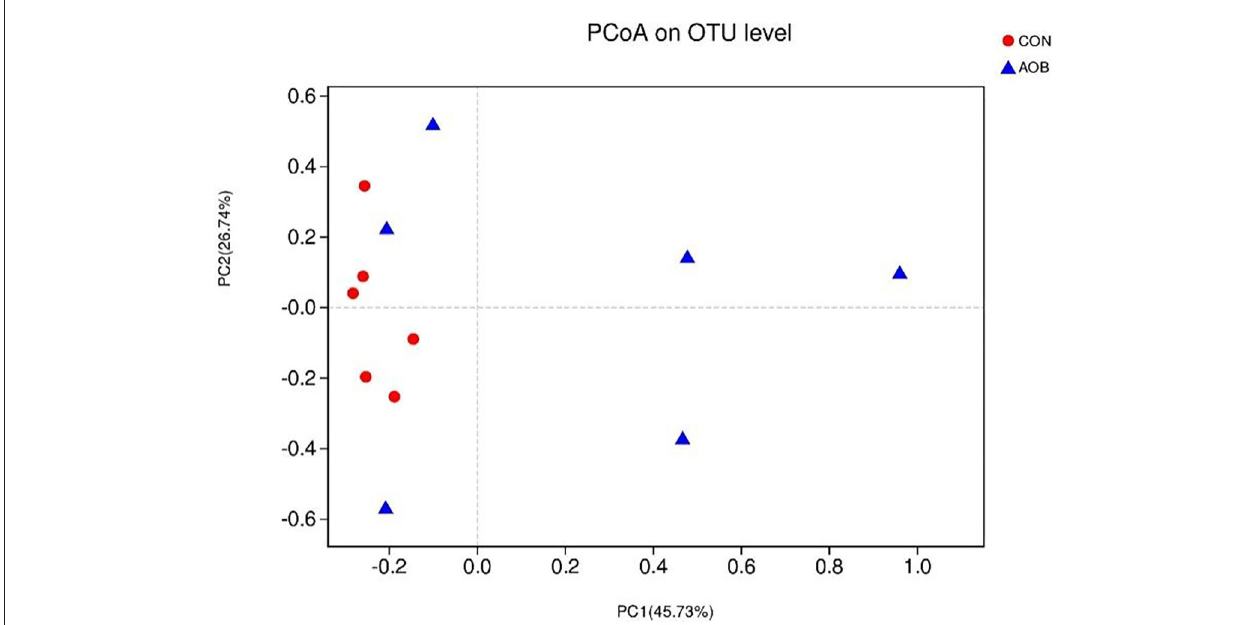
FIGURE 1 | Principal coordinates analysis of bacterial communities in milk from lactating cows fed TMR with supplementation of 0 (CON) and 60 g/d of bamboo leaf extracts (AOB), n = 6. PCoA, principal coordinates analysis; TMR, total mixed ration.